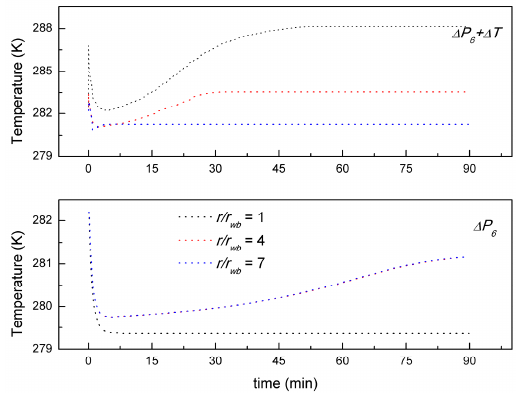
Figure 6. Temperature evolutions of Δ P 6 + Δ T and Δ P 6 at different wellbore radii r/r wb during production process.